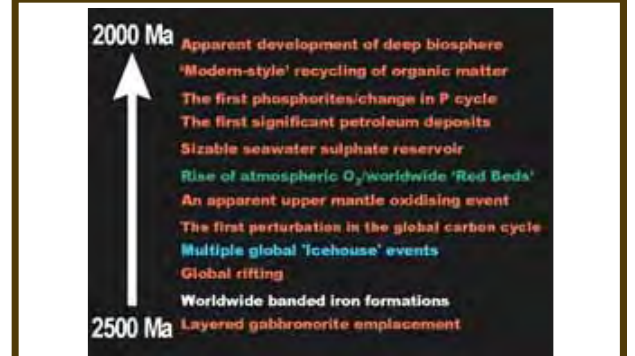
Figure 2. Major Early Palaeoproterozoic events (see explanation in